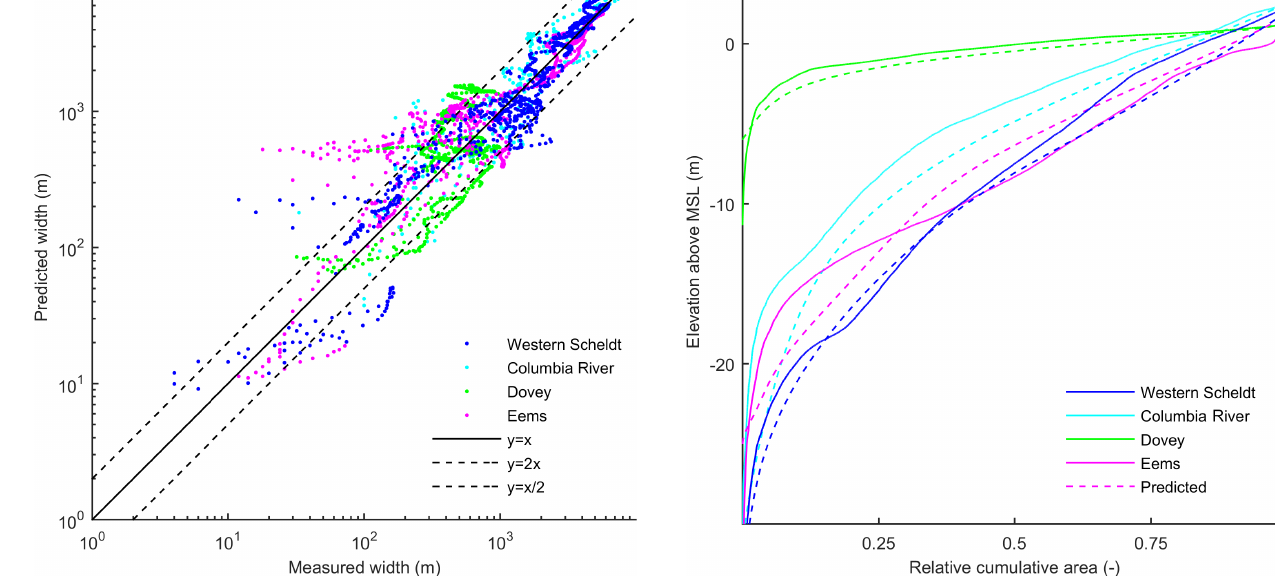
Figure 12. Hypsometry as summarised in a single curve for the en- tire estuaries. Solid lines are measured from bathymetry, and dashed lines are based on the